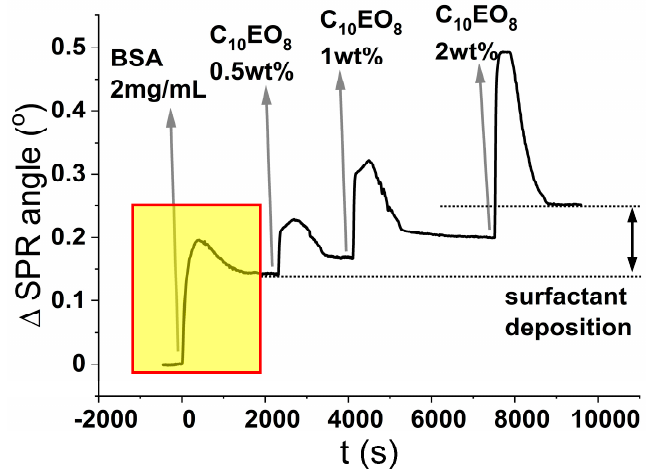
Figure 5. SPR sensogram of a kinetic titration for the adsorption of surfactant onto a pre-treated layer of BSA (highlighted in the yellow box).